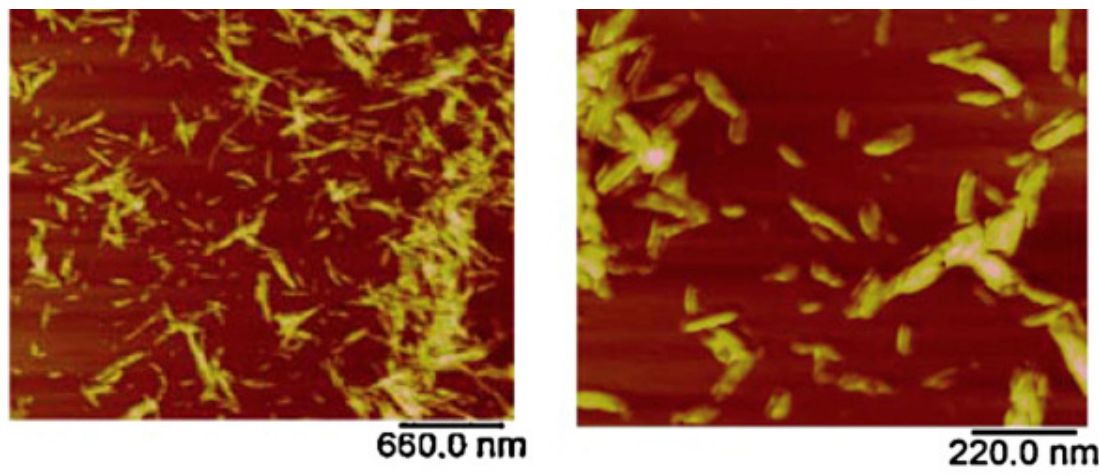
Figure 13. Atomic force microscopy (AFM) images of cellulose nanocrystals at a ) low and b ) high magnification. The length, width, and aspect ratio were 90–180 nm, 4–6 nm, and 26, respectively [81]. (Reprinted with permission from Nagalakshmaiah et al.,